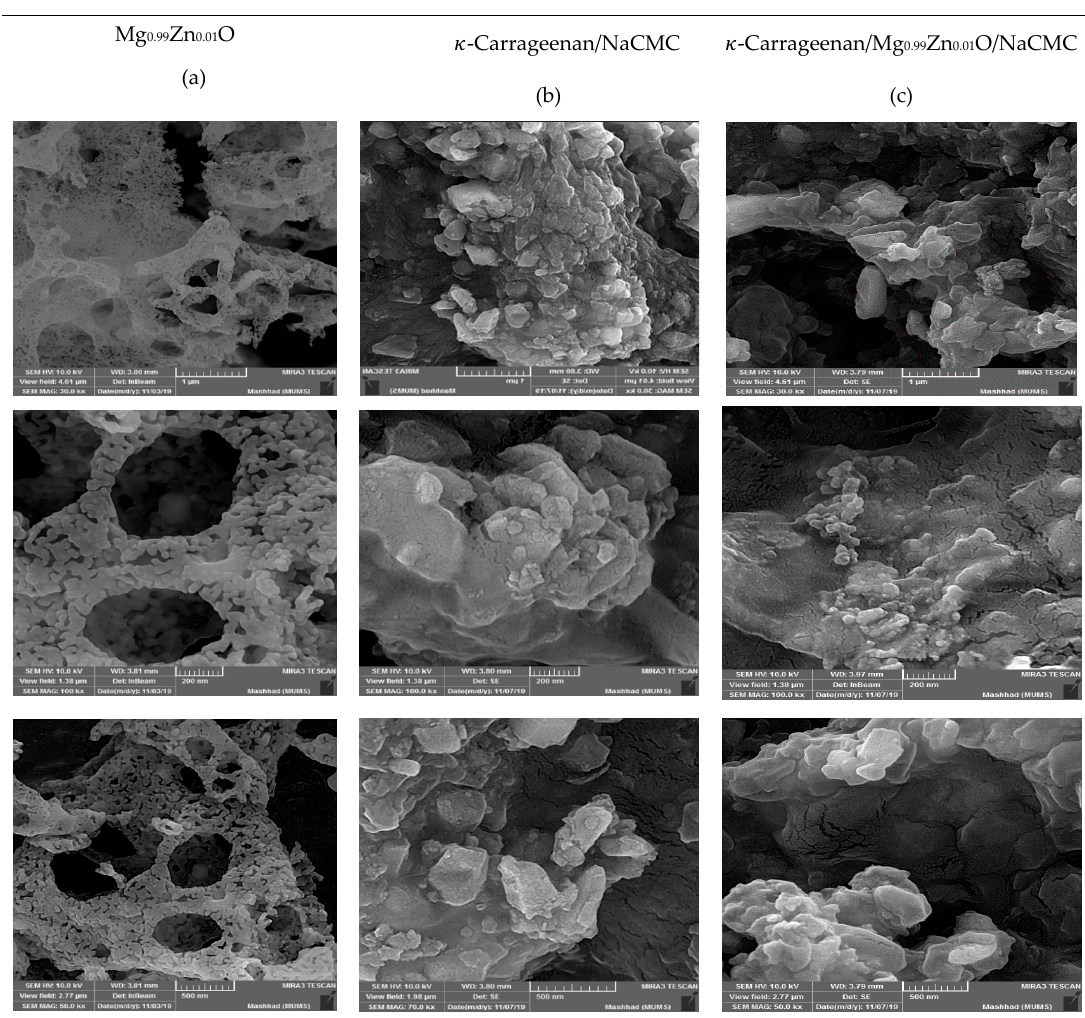
Figure 6. FESEM images of ( a ) Mg 0.99 Zn 0.01 O, ( b ) κ -carrageenan/NaCMC, and (c) κ -carrageenan/ Mg 0.99 Zn 0.01 O